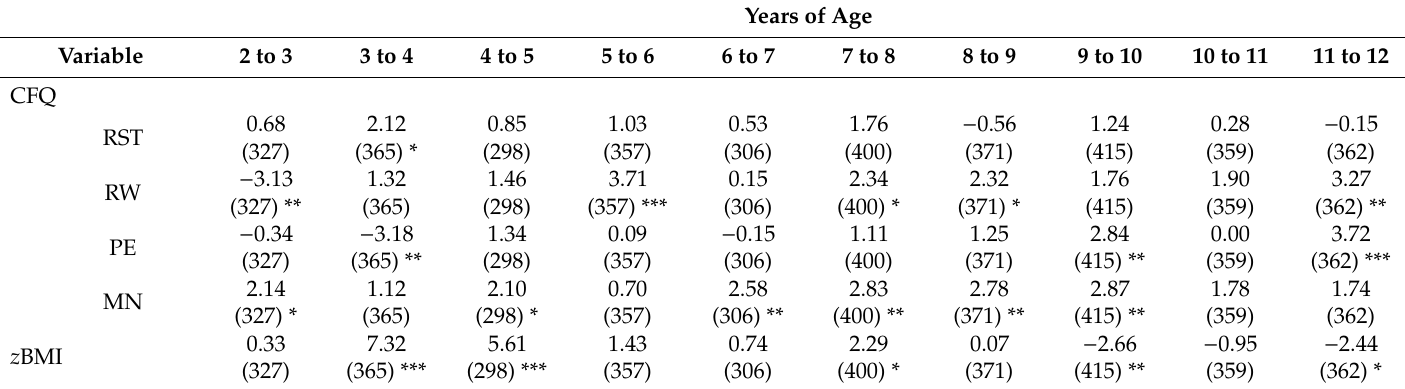
Table 3. Continuity of parental feeding practices and standardized child body mass